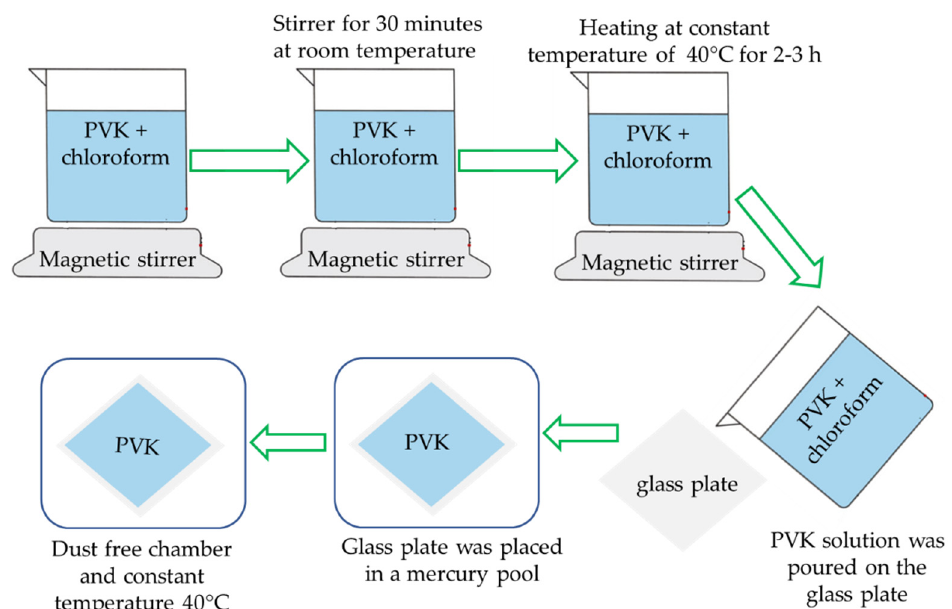
Figure 1. Schematic diagram of the thin film synthesis process. In order to obtain pinhole free and smooth film, precaution was taken to reduce the rate of vaporization, because solvent chloroform has high rate of vaporization. Therefore, whole assembly (tray filled with mercury and solution poured glass plate) was partially covered with another glass plate. This resulted in slow vaporization rate of